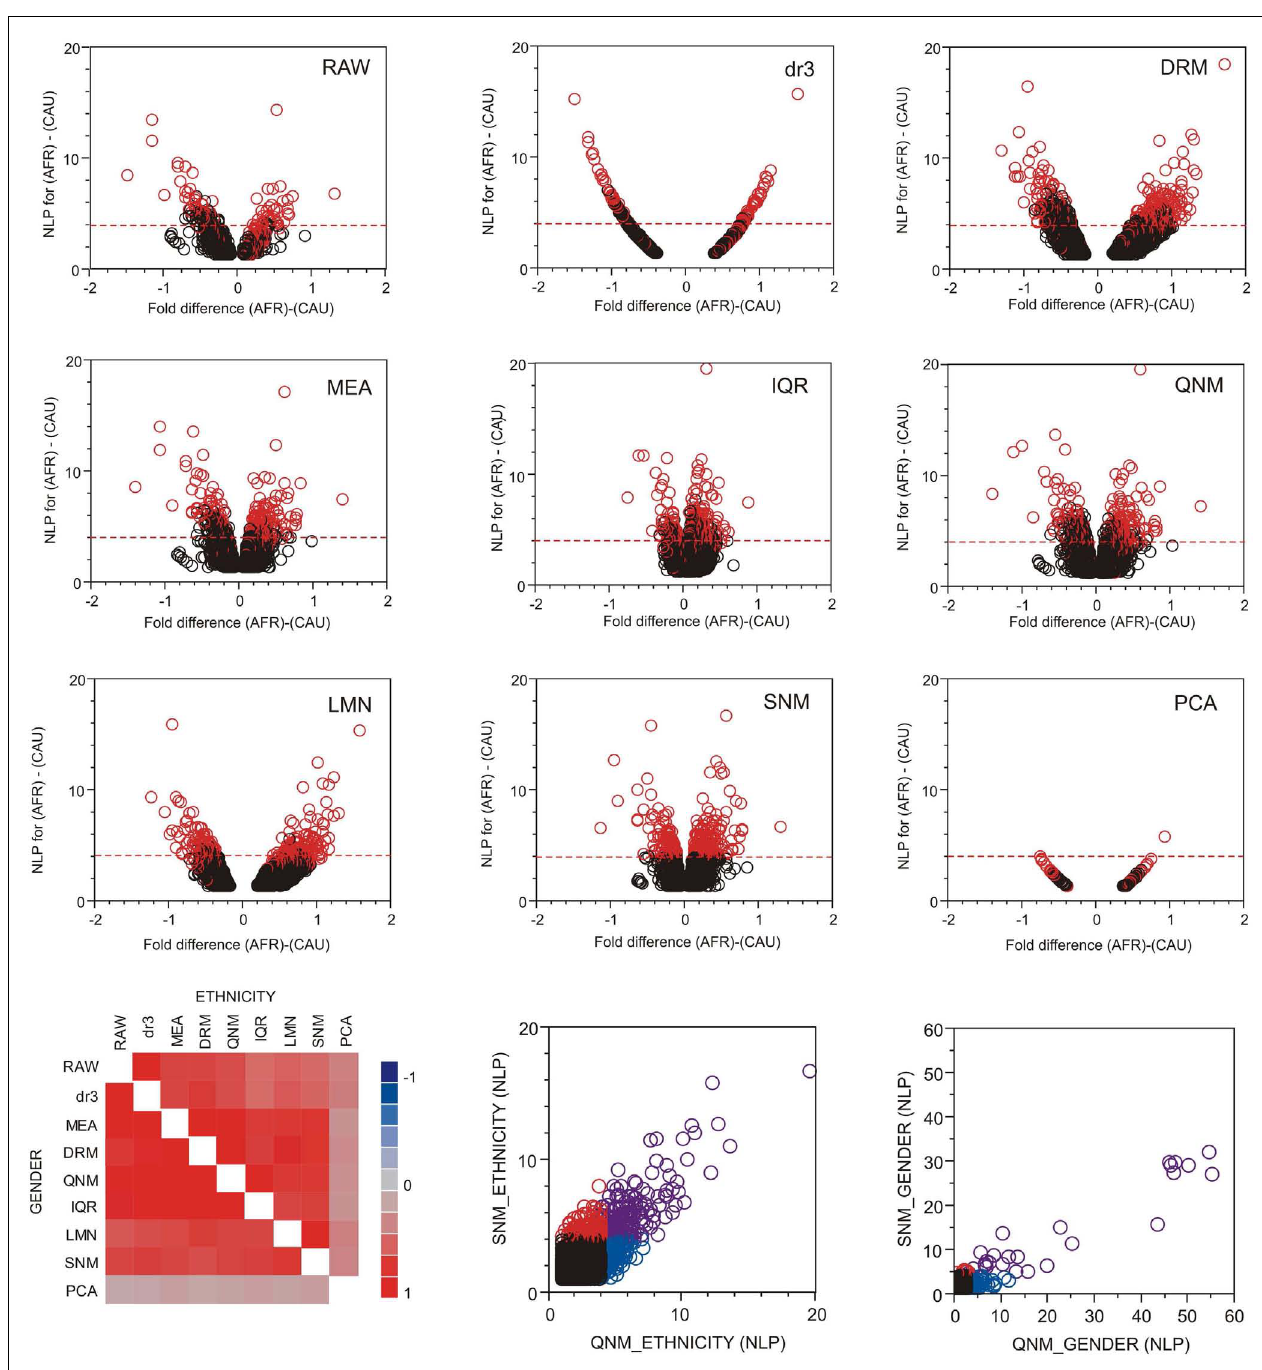
significant contrasts are significant in all methods, but this is not necessarily the case for the Gender comparison where Quantile normalization (QNM) over-represents the gender effect relative to all other methods.The heat map at the bottom left shows the pair-wise correlation of estimated effect sizes for all 14,343 probes for each normalization comparison, for ethnicity above the diagonal, and gender below